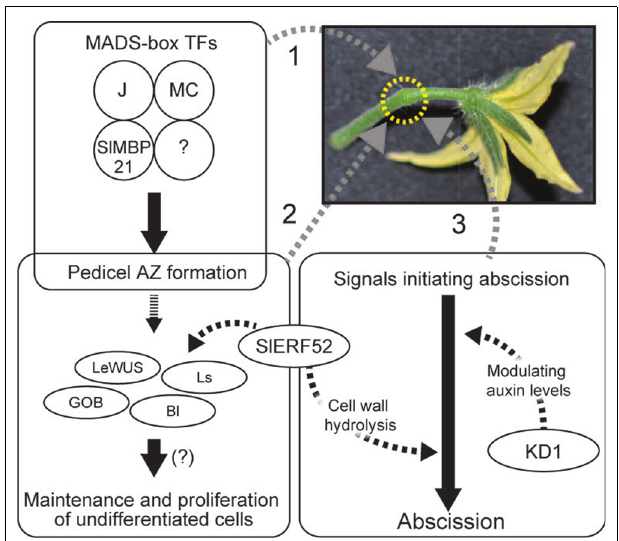
FIGURE 1 | Regulation of pedicel AZ functions. 1. MADS-box proteins form tetramers and regulate pedicel AZ formation. 2. Undifferentiated cells are maintained in the pedicel AZ. AZ-specific transcription factors may be involved in the maintenance and proliferation of the undifferentiated cells. Expression of these transcription factor genes requires the activity of SlERF52. 3. In response to abscission-initiating signals, KD1 and SlERF52 activate abscission by modulating auxin levels and up-regulating genes encoding cell wall hydrolysis enzymes,